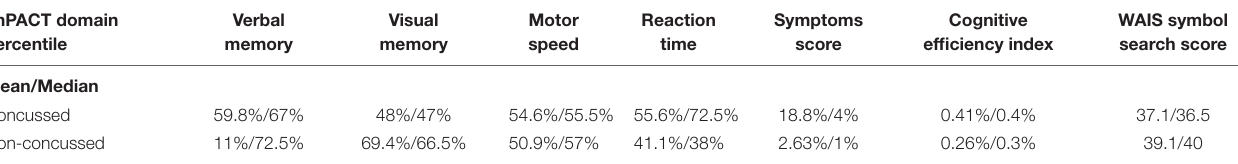
FIGURE 6 | Pathway enrichment analysis of miRNAs. Over-represented biological functions of let-7i-5p, miR-27b-3p, miR-142-3p, miR-107, miR-135b-5p computed by analyzing their validated molecular targets through FatiGo and David tools. On the left of the histogram are reported the over represented pathways, while, on the right the corresponding p -values of Fisher’s Exact Test. On the x -axis are reported the percentages of gene targets associated to biological functions. TABLE 3 | A summary of ImPACT (percentile score with regard to all ImPACT test takers) and WAIS